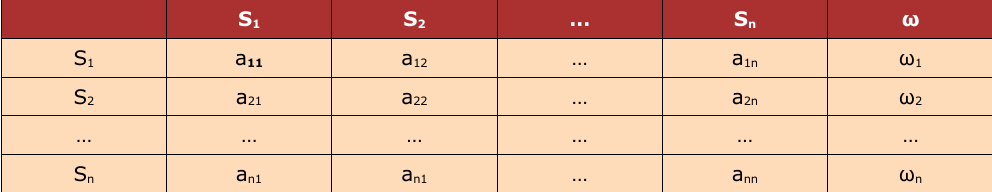
Table 1. pair-wise comparison matrix for prior nodes